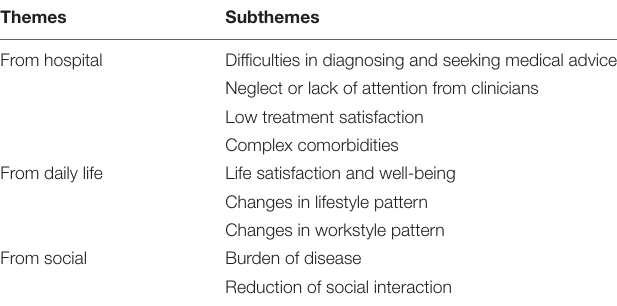
TABLE 1 | Overview of thematic